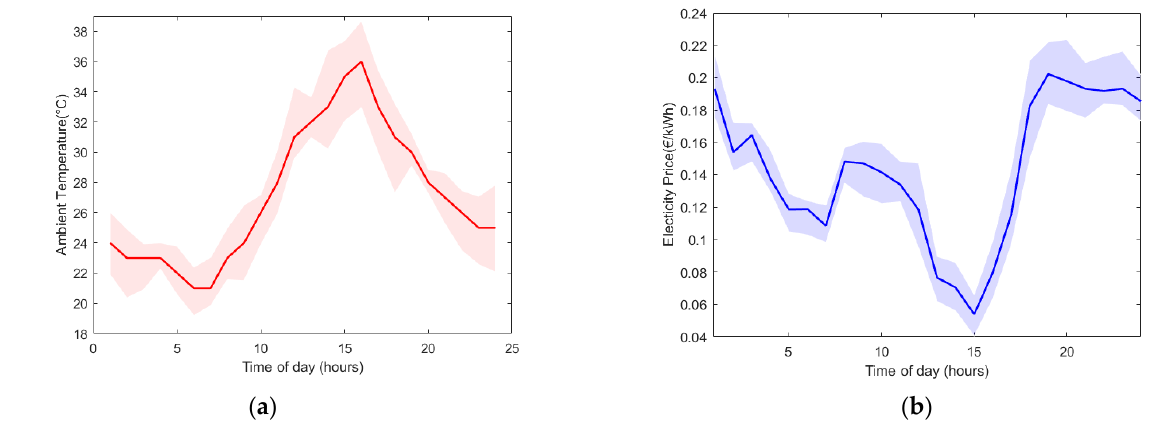
Figure 8. ( a ) Outdoor temperature. ( b ) Forecasted price of electricity. Various trajectories of the total ADN load consumption as well as of the total power generated by the wind park and the photovoltaics were randomly generated and the re- spective data are shown in Figure 9a,b, respectively.